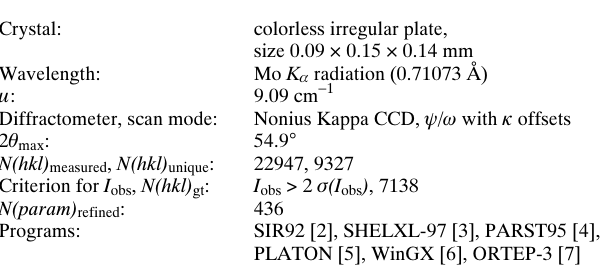
Table 1. Datacollection and